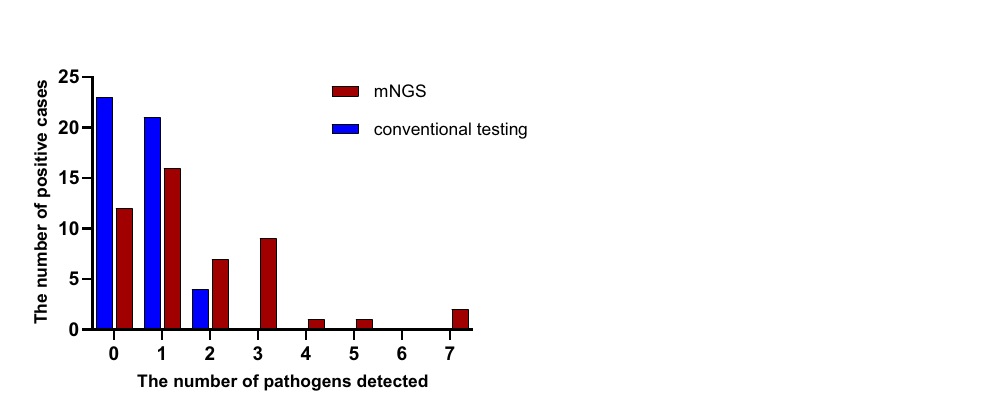
Figure 2. The distribution of pathogens number detected by two